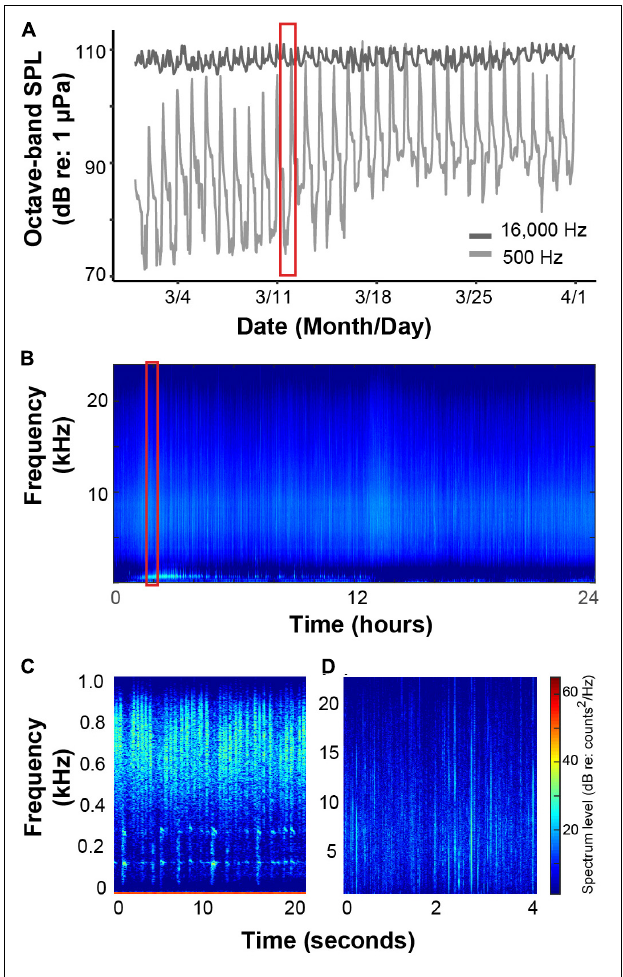
FIGURE 9 | Multiple biological sources contribute to high sound levels. Summary of sound pressure levels measured at Gray’s Reef National Marine Sanctuary (GR01). (A) Full 31-day period sound pressure levels in 500-Hz (light gray) and 16,000-Hz (dark gray). (B) Spectrogram focused on one day (red box in A) showing (C) low-frequency fish chorus and (D) snapping shrimp in higher frequencies.